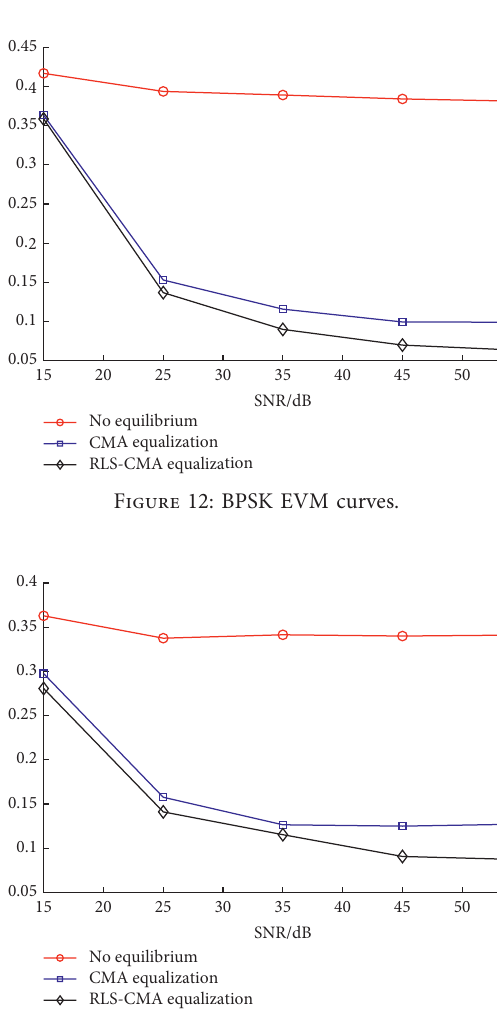
Figure 13: 8PSK EVM curves.